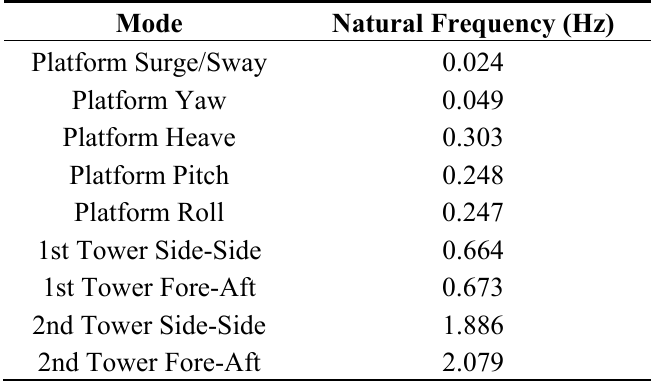
Table 7. Natural frequencies of the WindStar TLP.